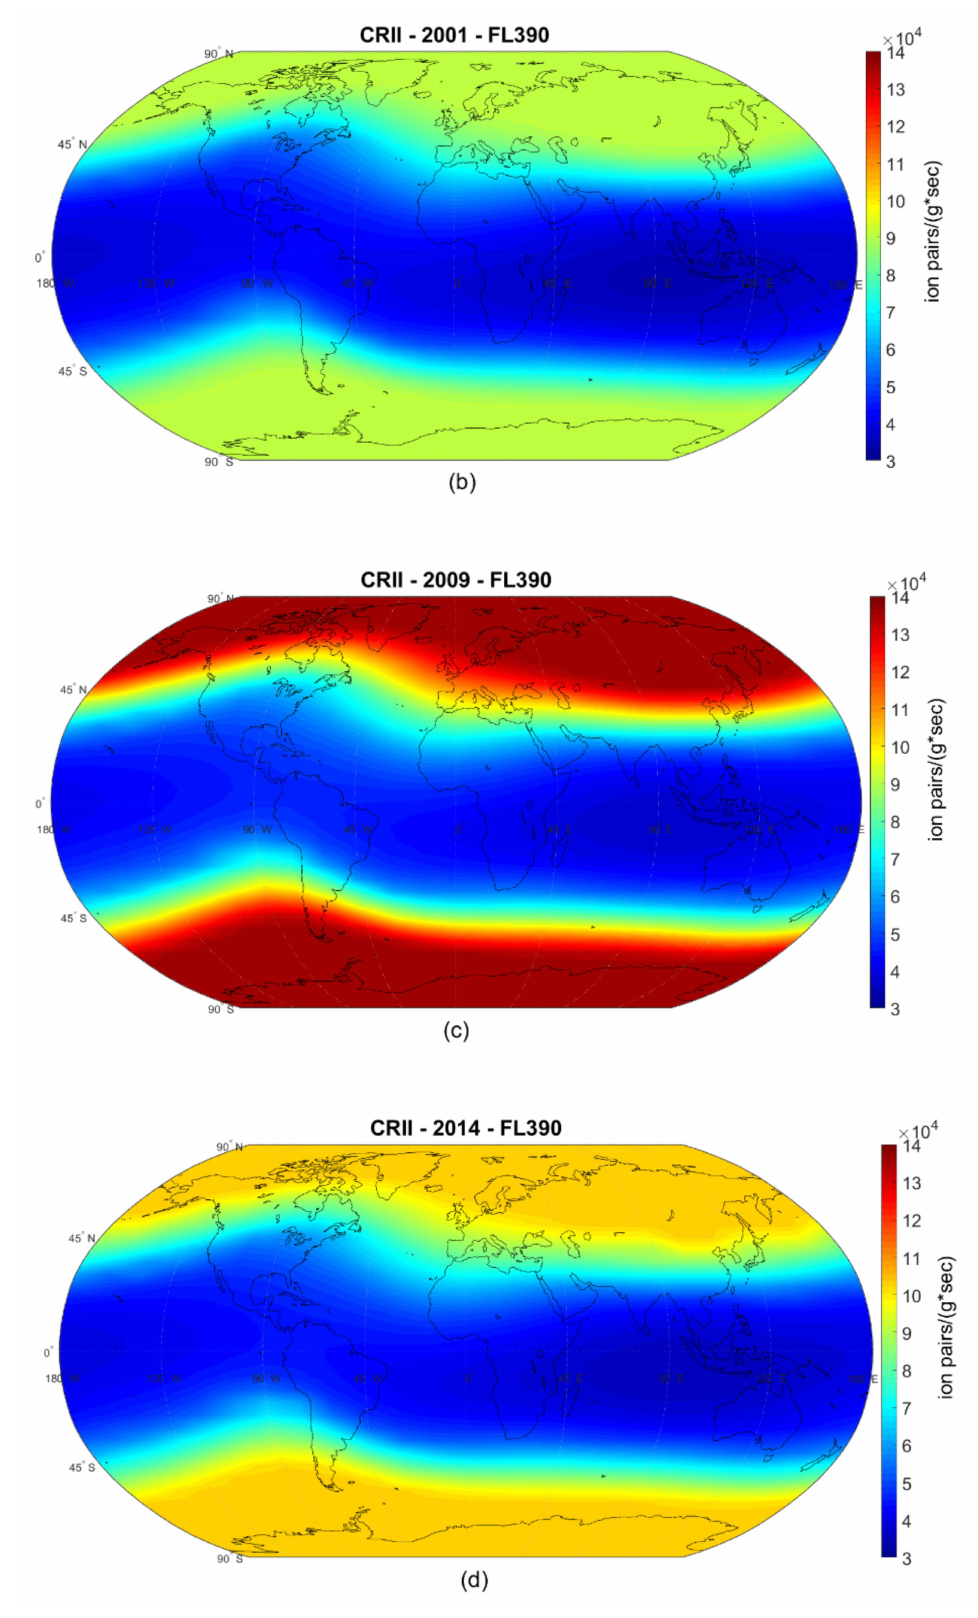
Figure 1. Maps of the CRII rate (ion pairs/(g*s)) at FL390: ( a ) during the minimum of solar cycle 23; ( b ) during the maximum of solar cycle 23; ( c ) during the minimum of solar cycle 24; ( d ) during the maximum of solar cycle